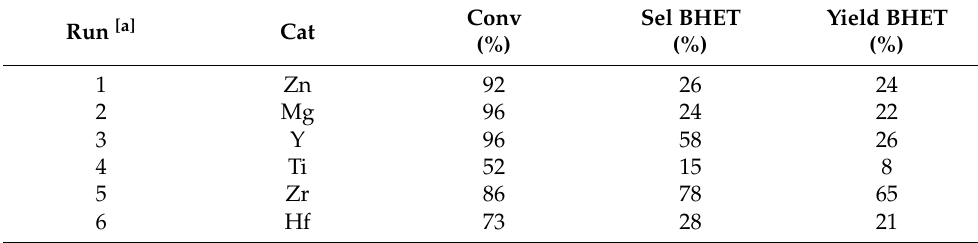
Figure 5. ESI-MS spectra of BHET obtained via crystallization from cold water. Among the investigated catalysts, Zn, Mg, and Y were able to almost quantitatively convert the whole PET amount after one hour. However, the best results were obtained with Zr amide, which reached a good percentage of degradation (86%) and very high se- lectivity (78%) in the production of BHET, with values that are comparable with the best results obtained with metal catalysts. Table 3. Glycolysis of PET under solvent-free conditions at 180 °C. Run [a]